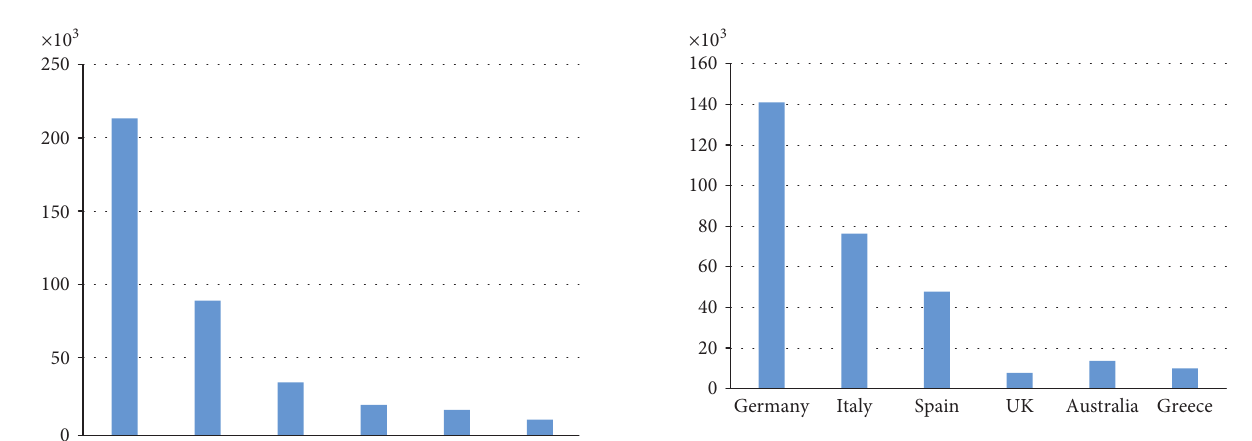
Figure 5: Solar PV production GWh in 2006 – 2015, IRENA statistic